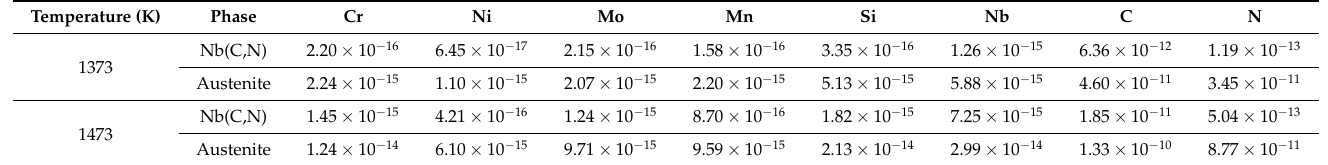
Table 4. Diagonal diffusion coefficients (m 2 s − 1 ) of different elements in Nb(C,N) and austenite at 1373 and 1473 K obtained from reduced diffusion matrices calculated using the TCFE9 and MOBFE4 databases (nine-element simulation) and for the respective equilibrium phase compositions given in Tables 2 and